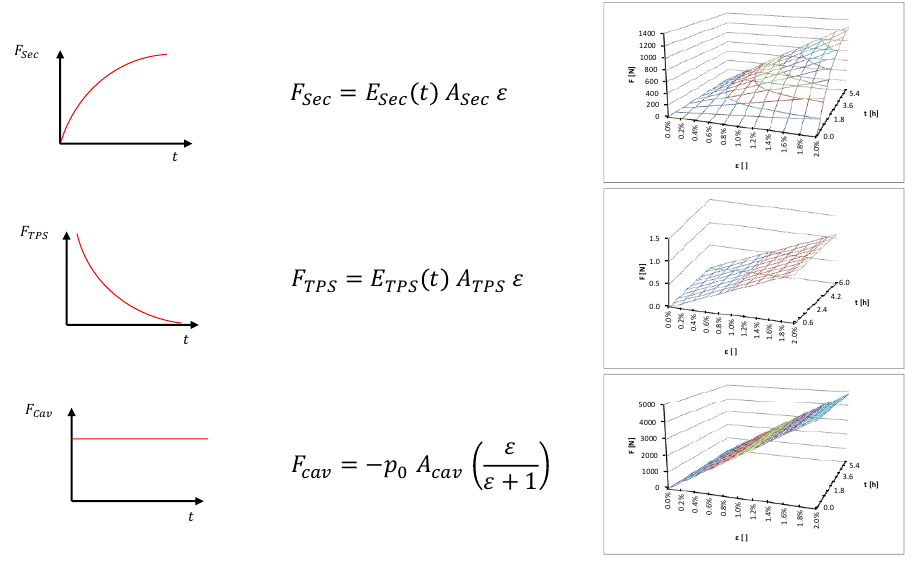
Fig. 11 Forces depending on the expansion of the edge bond and